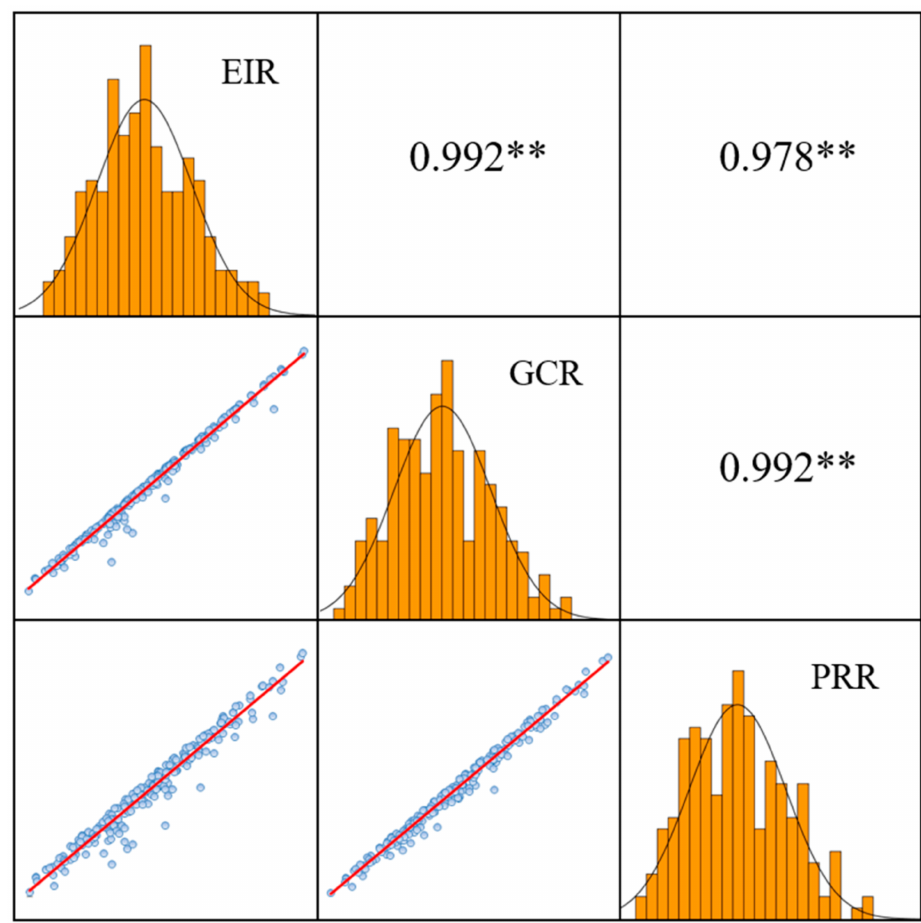
Figure 2. Distributions and correlations between three somatic regeneration traits with the average value across two years. The plots on the diagonal line show the phenotypic distributions of the EIR, GCR and PRR. The values above the diagonal line are Pearson’s correlation coefficients between every pair of traits. The scatter plots of correlations are shown in the areas below the diagonal, and the red lines in the plots represent the correlation trends. **: p ≤ 0.01; EIR: embryogenic callus induction rate; GCR: green callus rate; PRR: plantlet regeneration